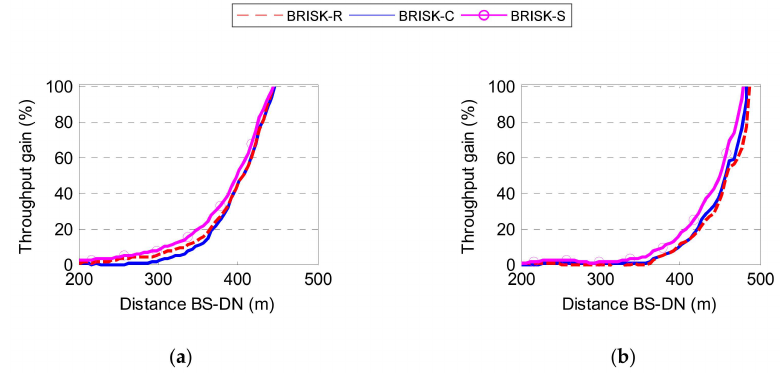
Figure 16. Throughput gain obtained with BRISK-C, BRISK-R and BRISK-S with respect to SH—15 RN web tra ffi c & non-symmetric scenario. ( a ) S1; ( b )